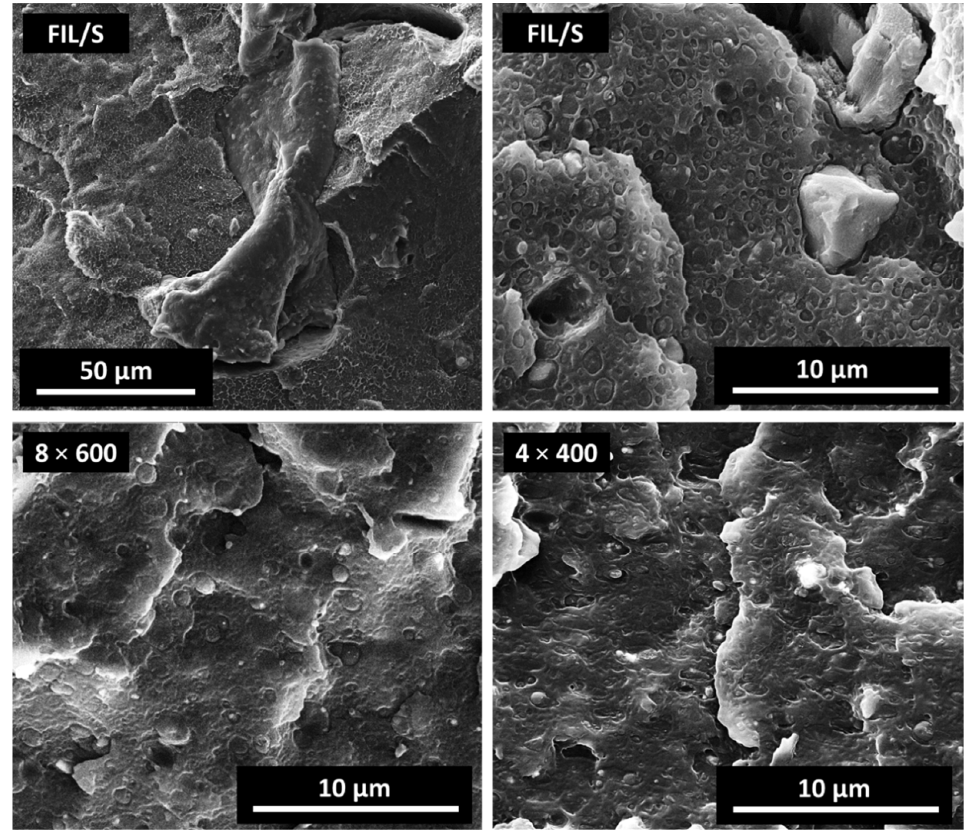
Figure 3. SEM micrographs of cryo-fractured surfaces of FIL/S, 8 × 600 and 4 × 400 samples. Comparing the morphology of the different materials, ball milling revealed a double effect on the structure of treated samples. First, large (few µm to tens of µm) inclusions with irregular shape, frequently observed in neat FIL/S, are practically absent in BM treated materials, evidencing a very effective homogenization induced by the milling. Such inclusions appear completely debonded from the FIL/S matrix and are the main responsible for the low elongation shown by FIL/S, representing defects and failure-starting points [27]. Large, film-like inclusions such as the one observed in the first panel of Figure 3 may be attributed to polymeric contaminants such as PET, not melted during the processing. As a second finding, globular inclusions of micrometric and submicrometric size, observed in large numbers in FIL/S (affected, again, by evident debonding and pull-out due to the low interfacial adhesion), are less evident in BM treated samples where they appear homogeneously dispersed and partially covered/anchored to the polymer bulk. Image analysis carried out on SEM micrographs showed that the area occupied by the dispersed phase (approximated by 2D elliptical shapes, see Supplementary Information) is much larger in FIL/S, than in the BM-treated samples. As shown in Table 2, the dispersed phase represents almost 20% of the fracture surface in FIL/S and is reduced to 7.4 and 4.6% in 8 × 600 and 4 × 400 samples, respectively. These observations underline a strong beneficial effect of the intimate mixing of the different polymeric phases induced by BM also at a micrometric level [17].